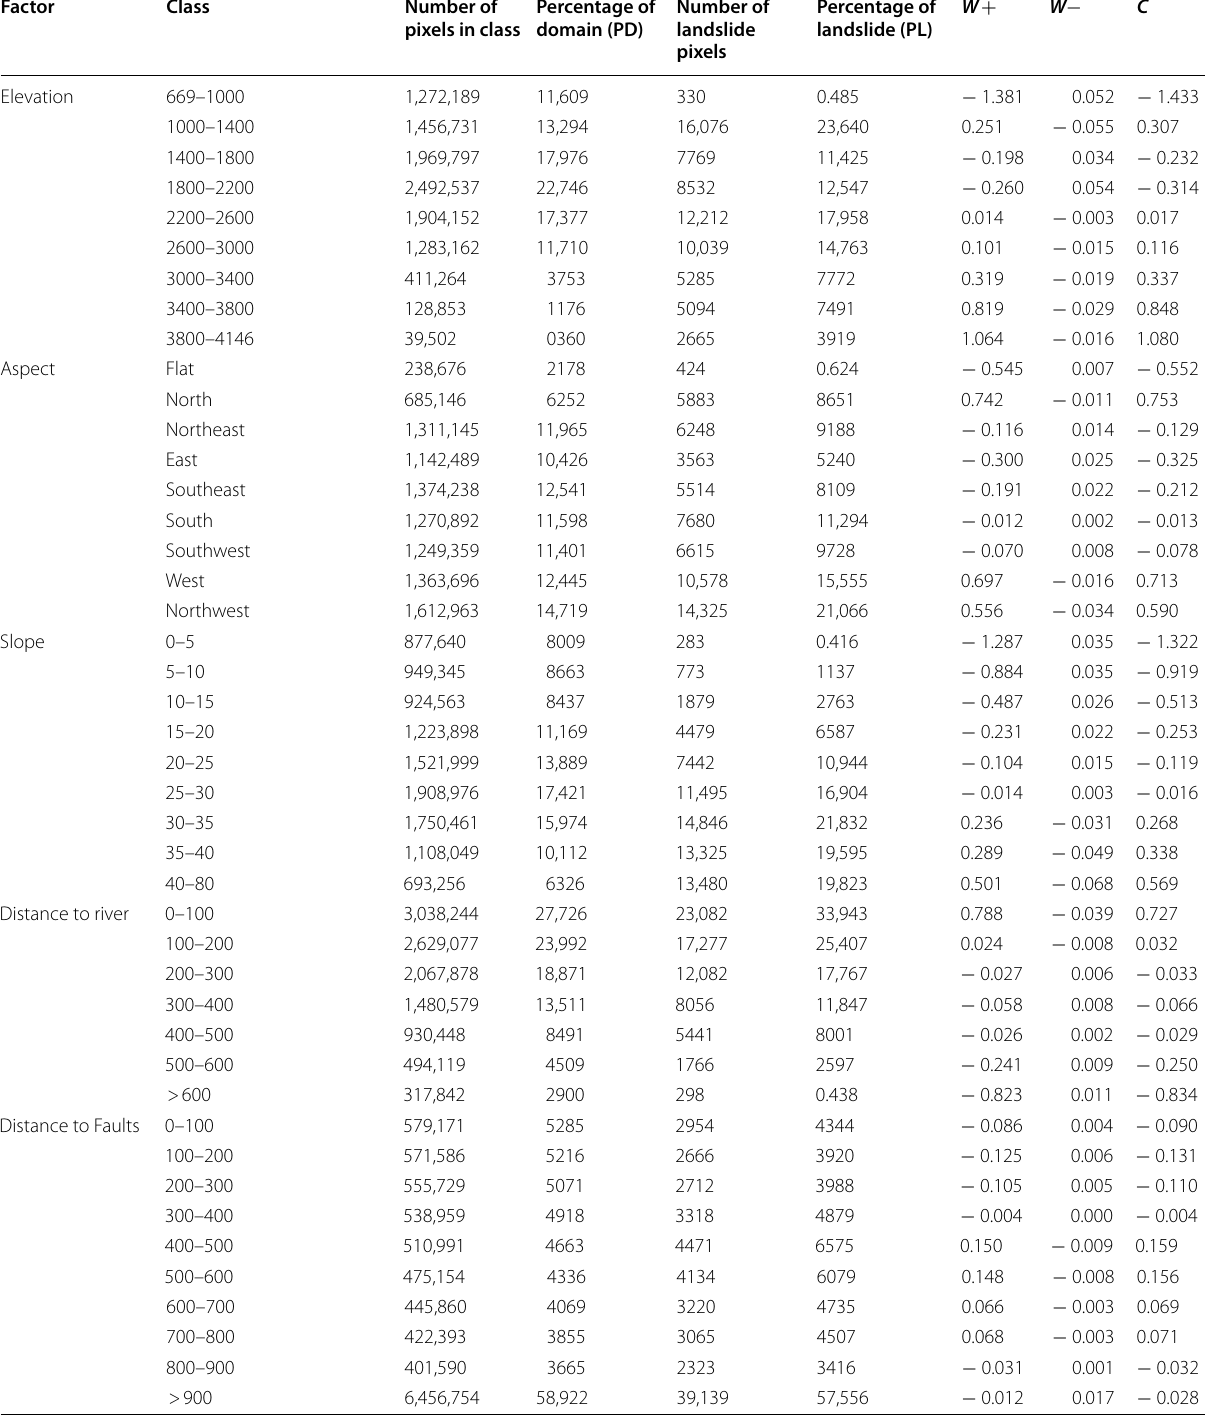
Table 2 WoE weights for the different classes of each parameter based on landslide occurrences Factor